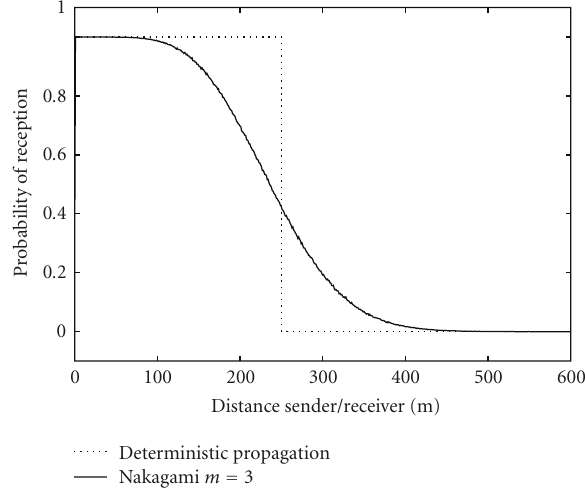
Figure 1: Probability of reception based on the distance between sender and receiver. Comparison of deterministic and probabilistic radio wave propagation